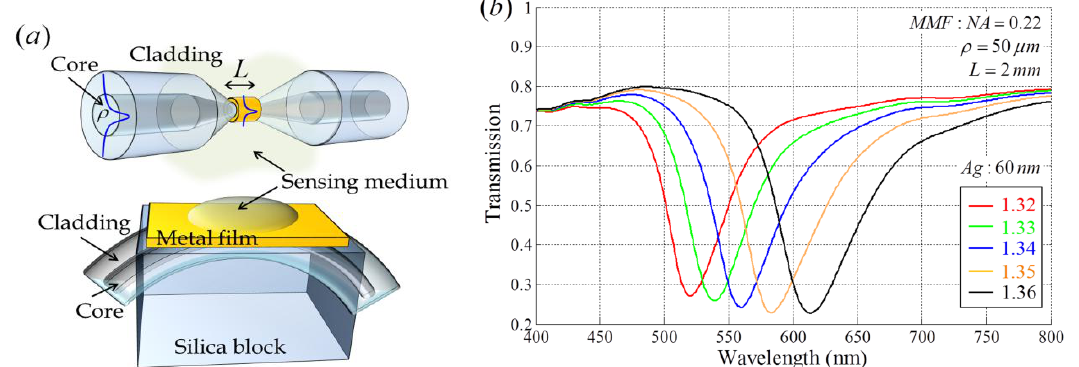
Figure 5. (a) Schemes for fiber-optic sensors with a tapered fiber and a D-shaped fiber (or polished fiber); (b) Transmission spectrum of a conventional fiber-optic SPR sensor with MMF (as shown in Figure 1(b)). The numerical aperture of the fiber is set to 0.22 and the core diameter is 50 μm. The length of the sensing region coated with a 60 nm Ag film is 2